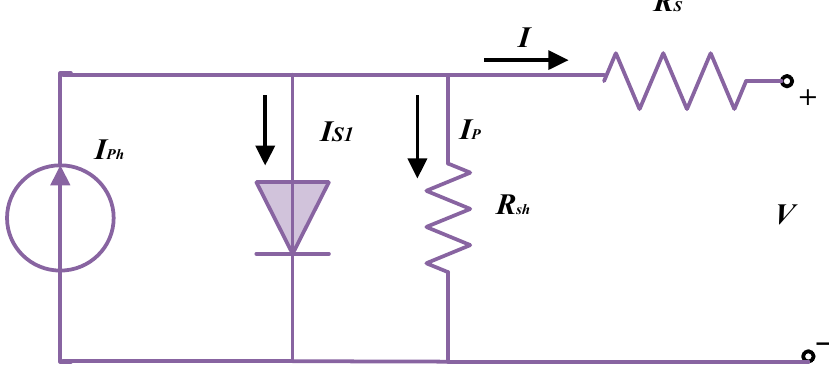
Figure 2. The electrical circuit of the single-diode model.